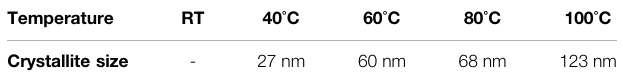
TABLE 1 | Evolution of the crystallite size of MAPbI 3 as a function of the annealing temperature ( in situ ) from room-temperature (RT) to 100 ° C.